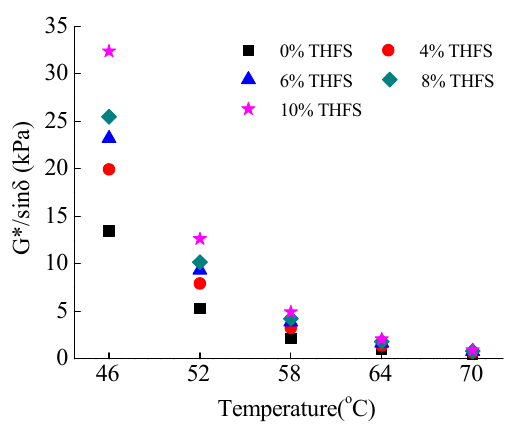
Figure 3. G*/sin δ Values of Asphalt Binders over Temperatures.